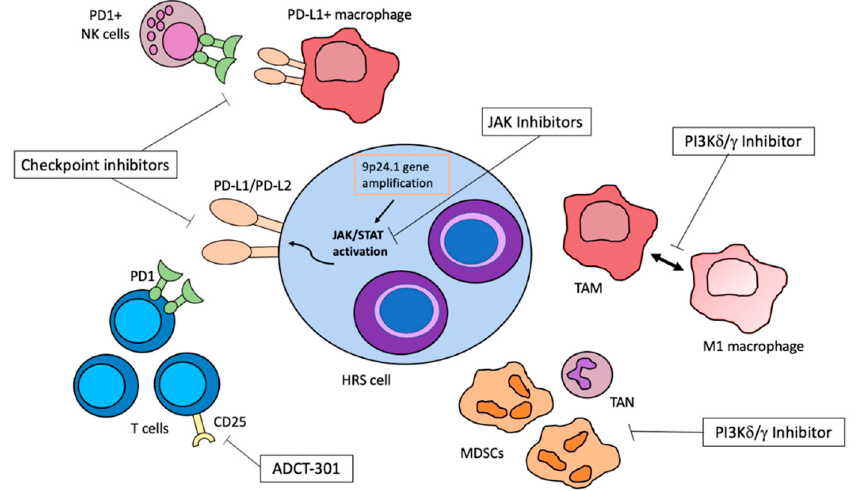
Figure 1. A schematic representation of novel therapeutic targets in classical Hodgkin lymphoma (cHL), exploiting tumor–microenvironment interactions. The black arrow represents a bimodal shift in macrophage polarization.